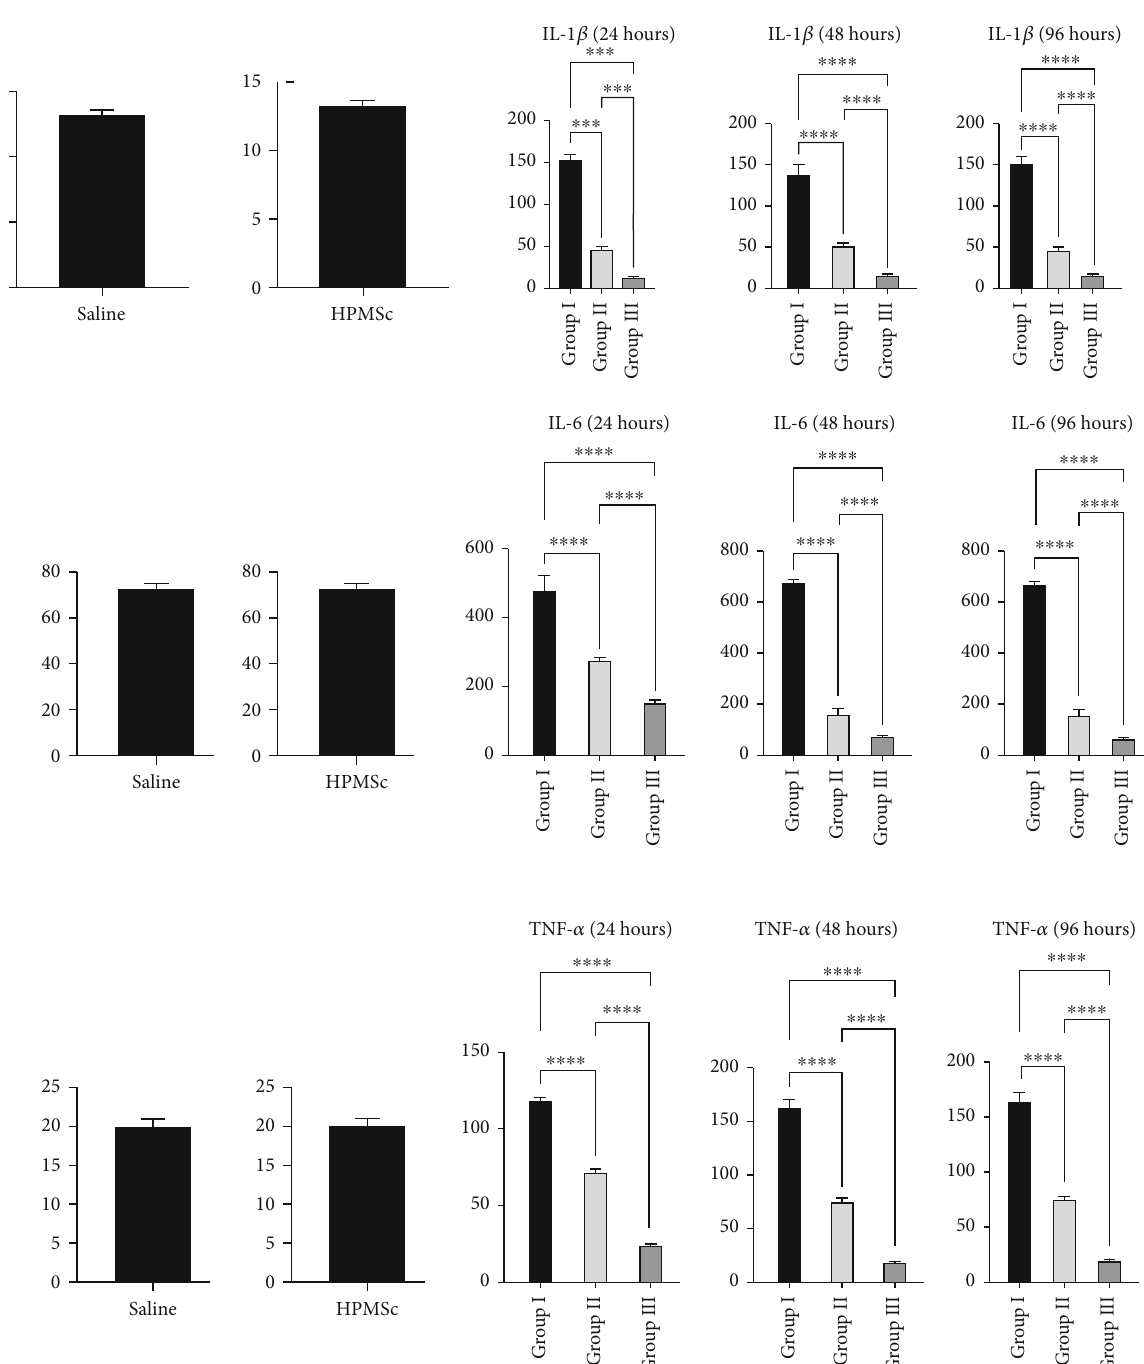
Figure 2: HPMSCs and analysis of cytokine levels after modeling and treatment of ARDS. Analysis of cytokine levels. Intratracheal injection of LPS increased expression levels the proin fl ammatory cytokine. In animals of the fi rst and second groups, during the fi rst three days, the levels of in fl ammatory cytokines TNF- α , IL-1 β , and IL-6 in the blood serum were signi fi cantly increased and remained at the same level during the entire observation period. The introduction of HPMSCs signi fi cantly limited the increase of in fl ammation marker levels in the third group ( ∗∗∗∗ P < 0 : 0001